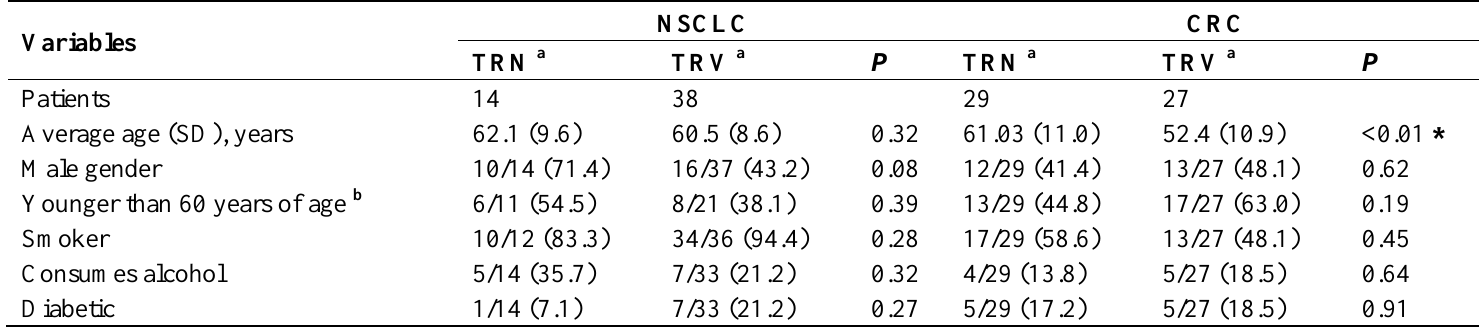
Table 2. Clinical and metabolic parameters in non-small cell lung carcinoma (NSCLC) and colorectal cancer (CRC) patients with transition or transversion mutations in KRAS